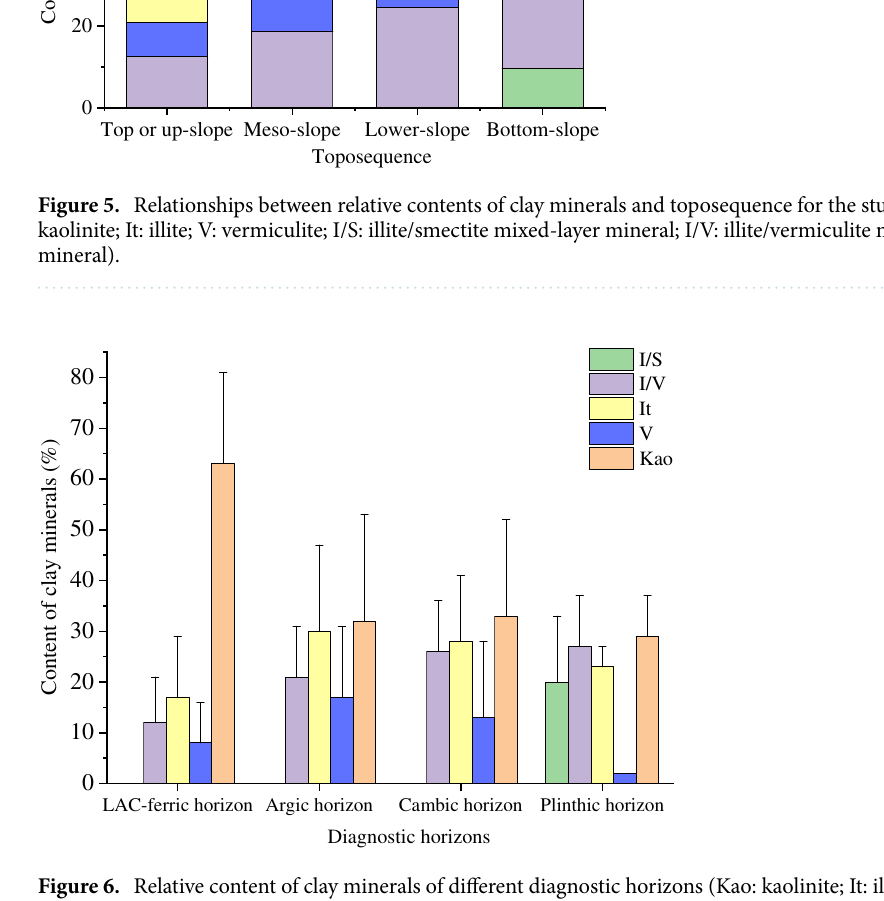
Figure 6. Relative content of clay minerals of different diagnostic horizons (Kao: kaolinite; It: illite; V: vermiculite; I/S: illite/smectite mixed-layer mineral; I/V: illite/vermiculite mixed-layer